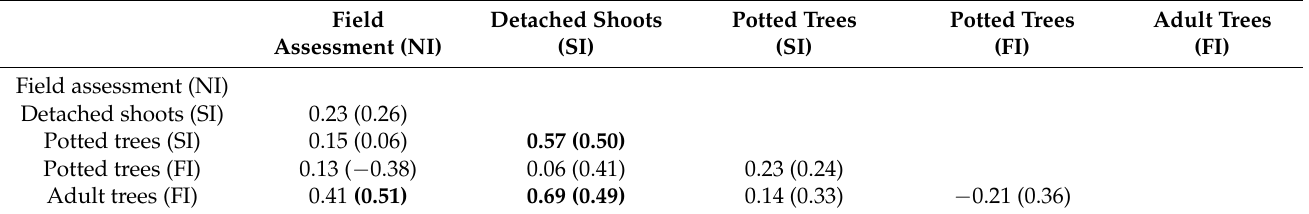
Table 4. Spearman ´ s correlation coefficients between different European canker phenotyping tests using AUDPC or disease incidence (in brackets) as phenotyping variables in a collection of apple accessions in Villaviciosa (north-western Spain). NI, SI, and FI stand for natural infections, single isolate, and field inoculum, respectively. Bold font indicates that the correlation is significant at p <